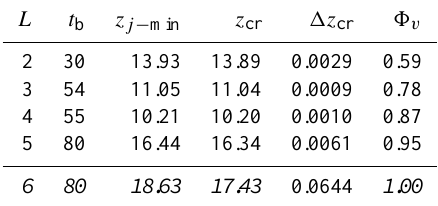
Table 7. Uncino landslide case study. Results of progressive cali- bration. Key: L , t b , z j − min , z cr ,(cid:49)z cr ) : model parameters concern- ing calibration (for explanation, cf. text); (cid:56) v ) fitness obtained by validating the “average kernel”, obtained in calibration, against the 6 dates of activation. In italics, results obtained when calibrating the model by using all the six available dates (no validation